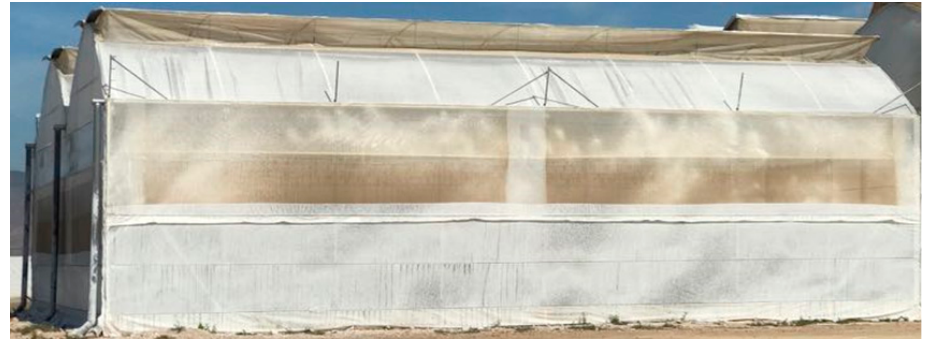
Figure 1. Greenhouse with fan-pad system.